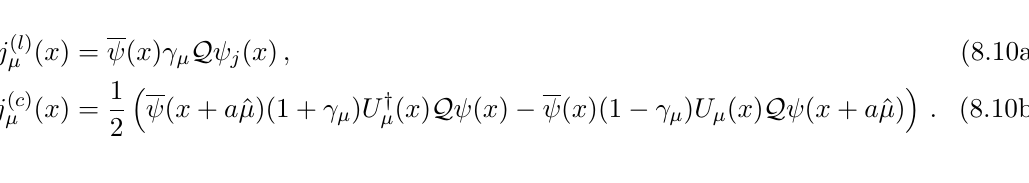
Figure 9 . The integrand with respect to the variable | y | leading to a HLbL computed in scalar QED, together (for comparison) with the integrand for the neutral pion-pole computed with a VMD form factor. The integrals over | x | and cos β have already been performed at this stage. Here Method 1 is used with kernel L (2)